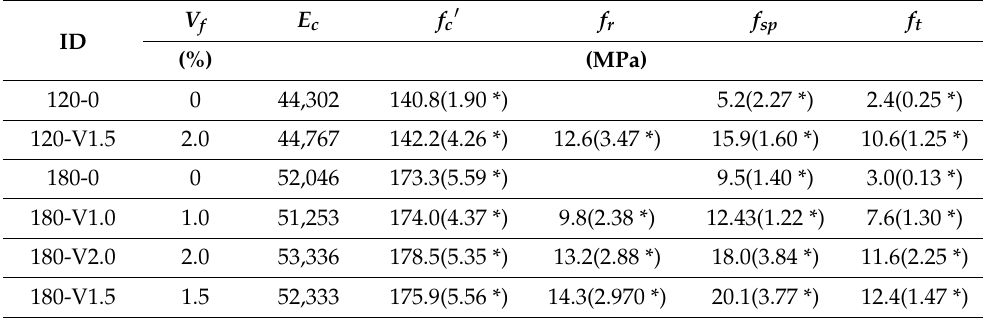
Table 3. Mechanical characteristics of used